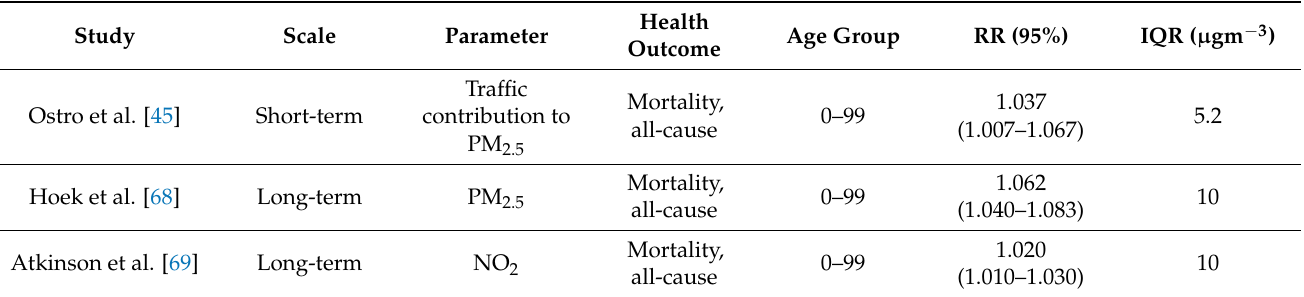
Table 2. Short-term and long-term epidemiological studies selected for the calculation of the health impact functions used in this